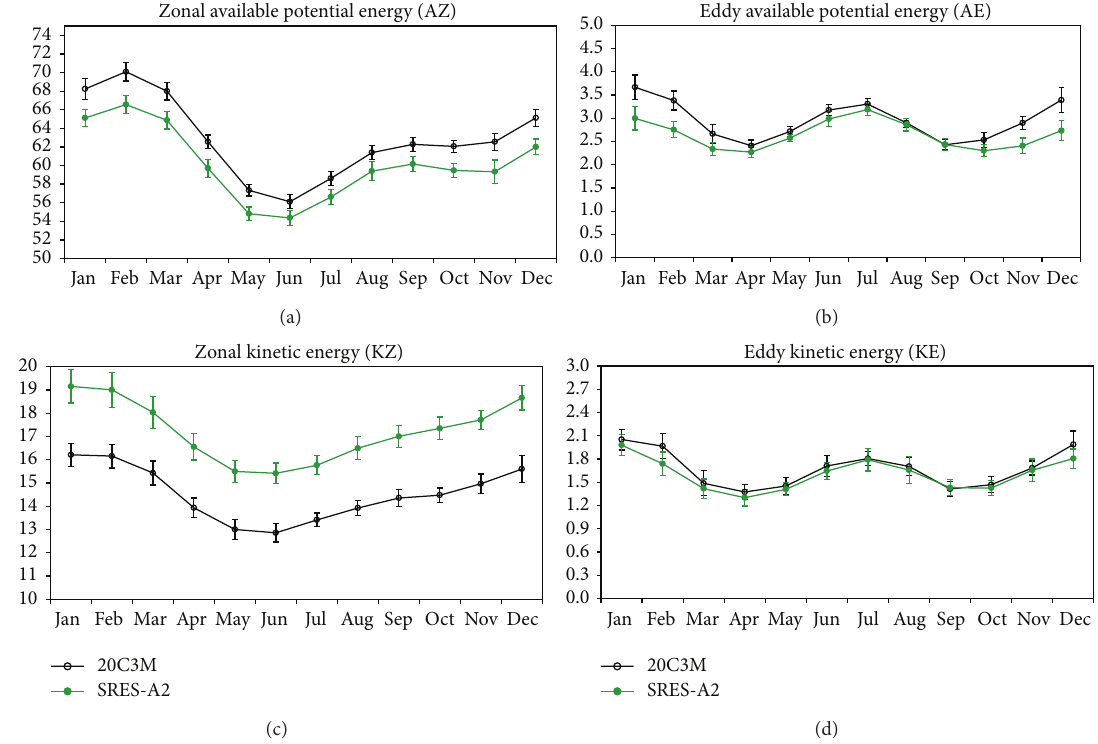
Figure 8: Mean SDLEC energy terms for the period 1979–1999 (20C3M) and 2079–2099 (SRES-A2). Results for 20C3M and SREAS2 are based on an average from CGCMs results (CRNM, CGCM, and ECHAM5). Error bars indicate 95% confidence intervals about the mean. Units are 10 5 Jm −2